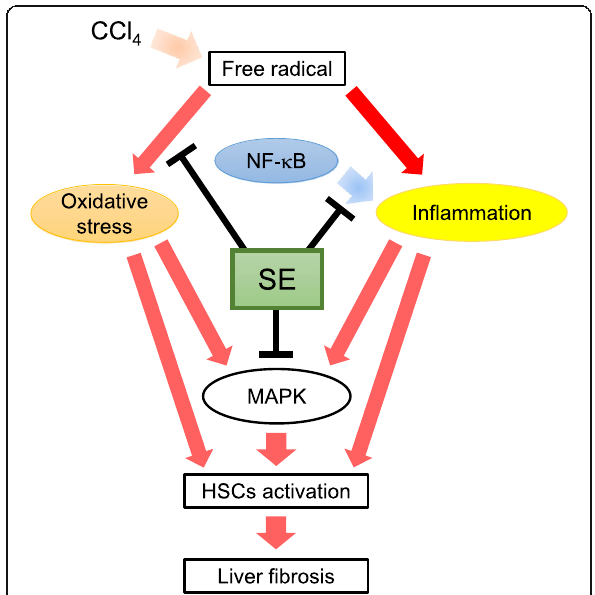
Fig. 9 Proposed protective mechanism of SE on CCl 4 -induced liver